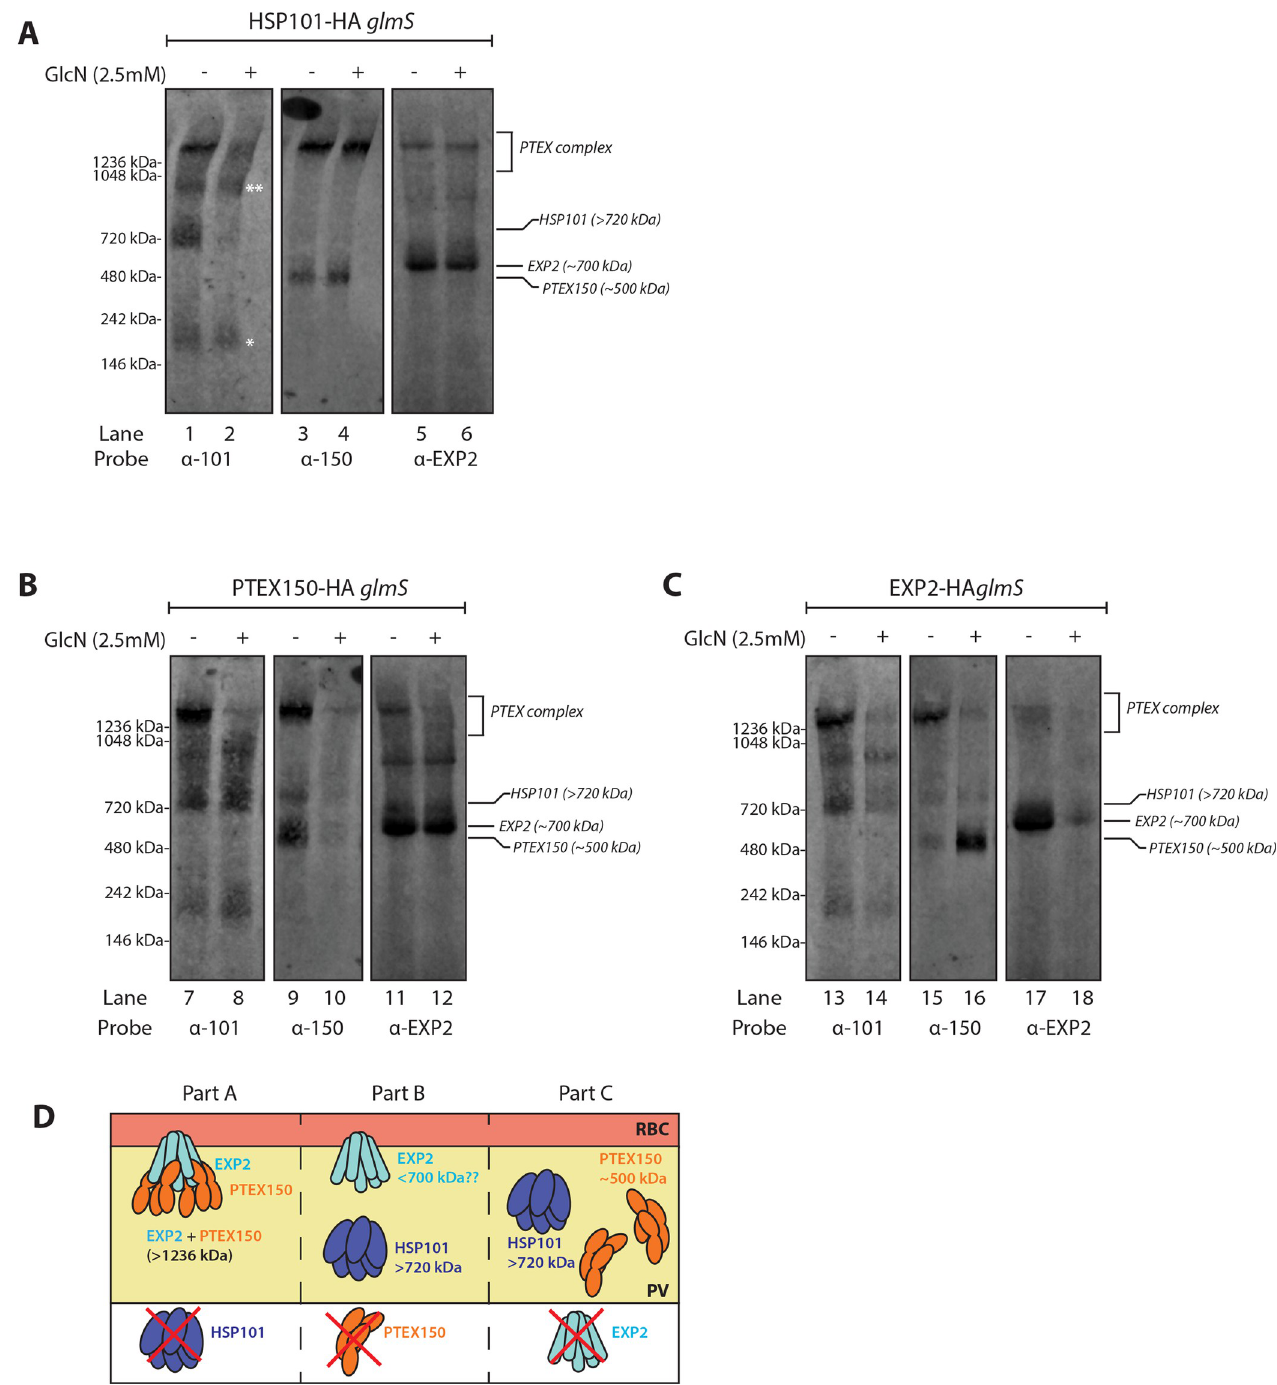
Fig 2. Knockdown of HSP101 does not disrupt the stability of the EXP2/PTEX150 subcomplex. (A), (B), and (C) BN-PAGE analysis of PTEX-HA glmS parasite lines following protein knockdown enables the effects on PTEX complex formation to be examined. Saponin-lysed pellets were lysed with 1% digitonin, separated on 4–12% NativePAGE gel, and analysed via western blotting using PTEX-specific antibodies. Knockdown of EXP2 and PTEX150 prevented the formation of a > 1236 kDa PTEX subcomplex. Knockdown of HSP101 in contrast, did not disrupt the ability of PTEX150 and EXP2 to form a > 1236kDa complex free of HSP101. � and �� are two non-specific bands observed with rabbit anti-HSP101 antibody. (D) Schematic summarising the impact of knocking down individual PTEX components with regards to complex formation.